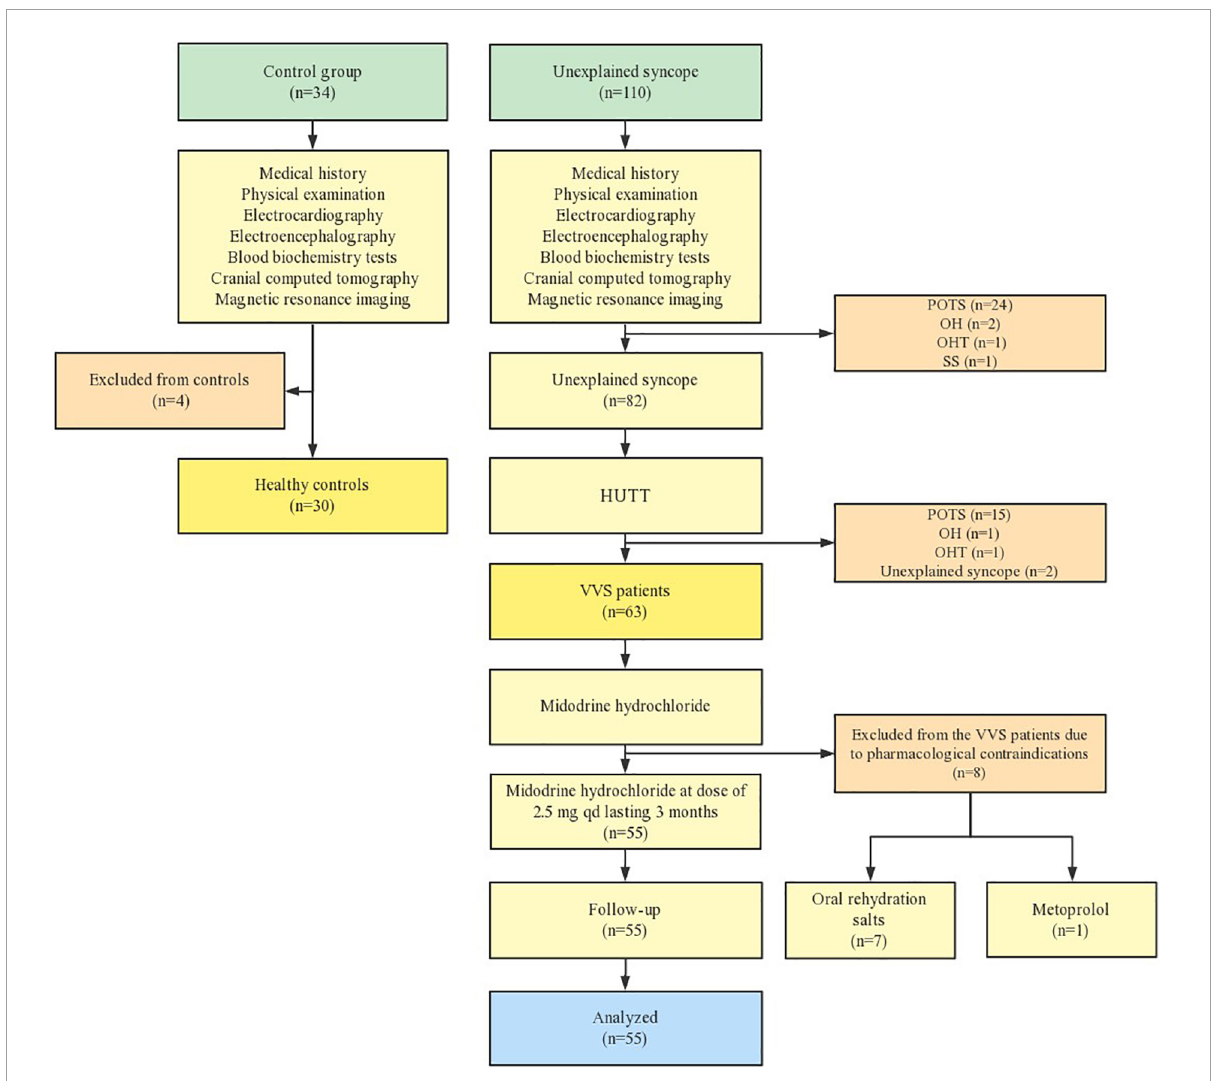
FIGURE1 Flow chart of participants selection. POTS, postural tachycardia syndrome; VVS, vasovagal syncope; OH, orthostatic hypotension; OHT, orthostatic hypertension; SS, situational syncope; HUTT, head-up tile